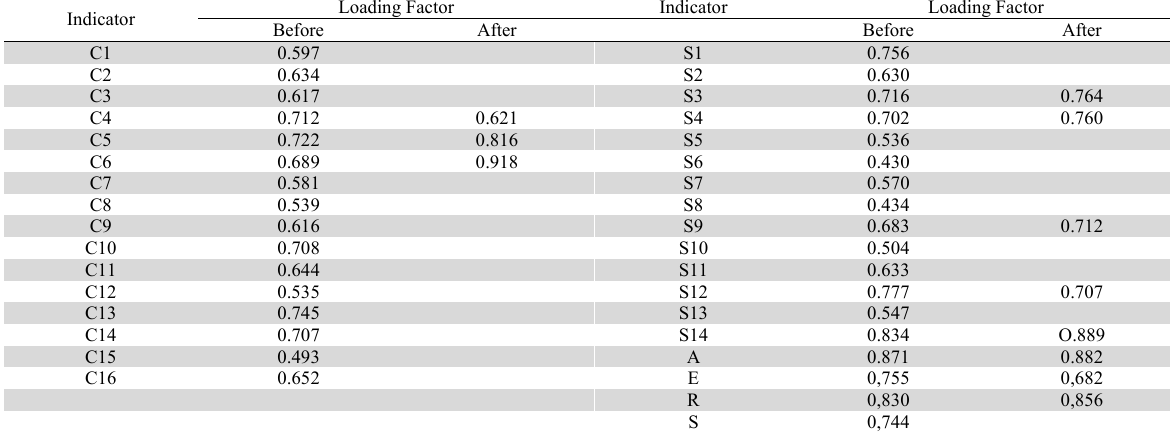
Loading factor estimate